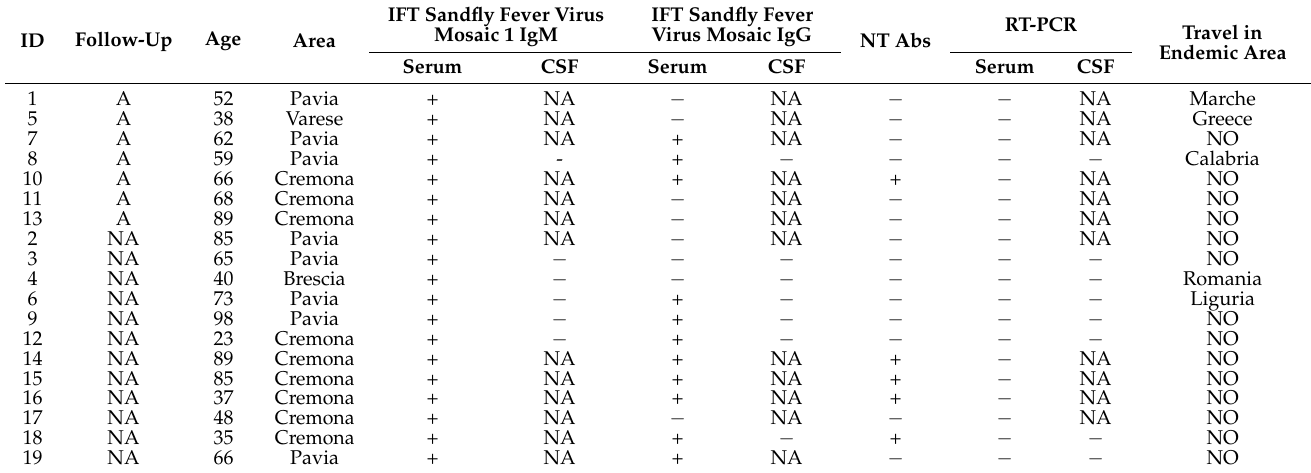
Table 2. Phlebovirus outbreak (summer 2013) in 19/51 patients in Lombardy